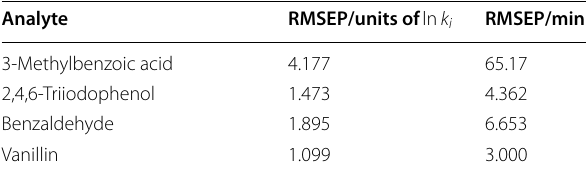
Table 3 RMSEP values for the test set analytes